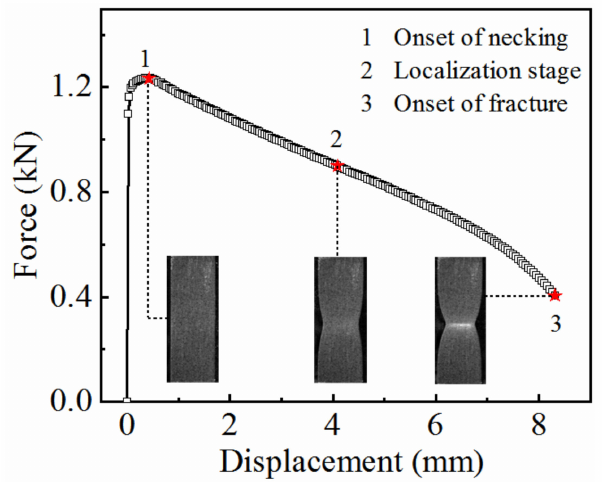
Figure 5. Force–displacement curve of 7075 aluminum alloy at a temperature of 350 ◦ C and a strain rate of 0.01 s − 1 .